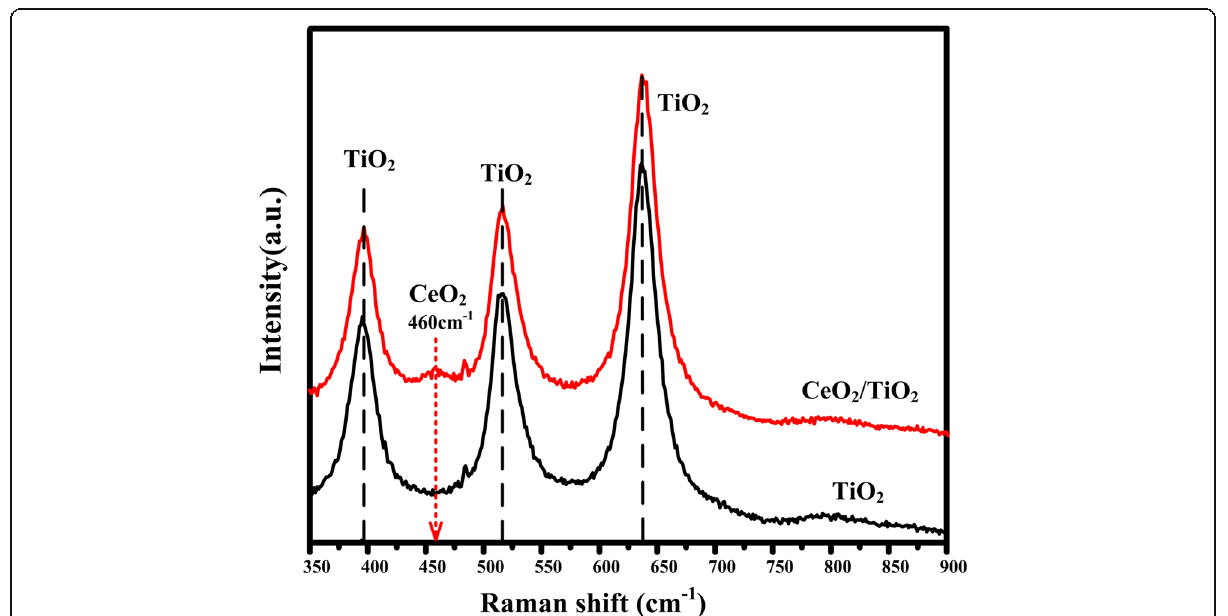
Fig. 7 Raman spectra of pure TiO 2 NTs and CeO 2 /TiO 2 heterojunction, indicating CeO 2 NPs were successfully loaded into the TiO 2 NTAs